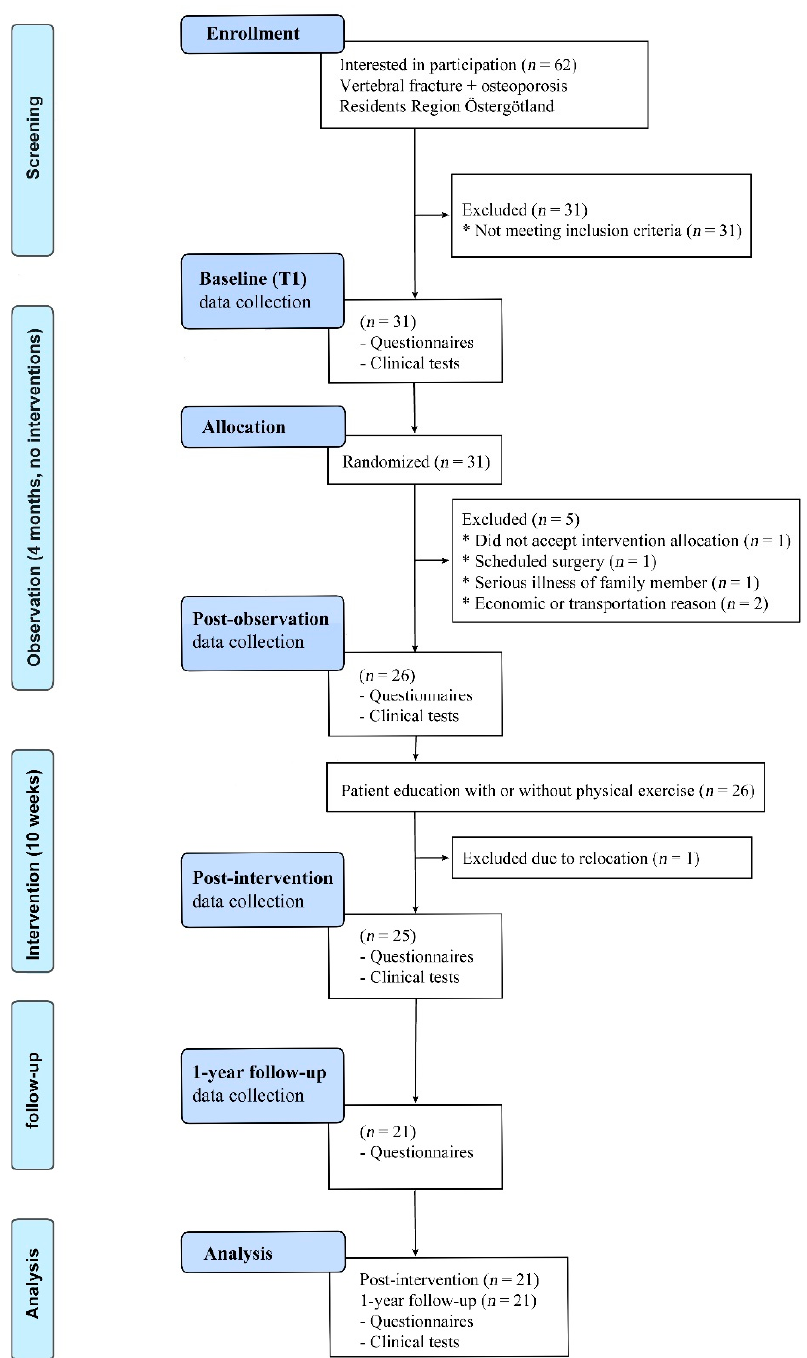
Figure 1. CONSORT flow chart. Patients were tested clinically and evaluated by questionnaires at four time points: (1) at baseline; (2) after a passive observation time of 4 months; (3) post-intervention of patient education including weekly theory sessions for 10 weeks with or without additional group training; and (4) at the 1-year follow-up after the intervention. In the current study, only participants with data from baseline, post-intervention and the 1-year post-intervention follow-up were included ( n = 21). Regarding the T group: 10 participants were randomized at baseline, 7 attended intervention, and 5 attended the 1-year post-intervention follow-up. Similar figures for the TMMY group were: 10 randomized, 8 at intervention, and 7 at the 1-year post-intervention follow-up. The TPh group figures were: 11 randomized, 10 at intervention, and 9 at the 1-year post-intervention follow-up.